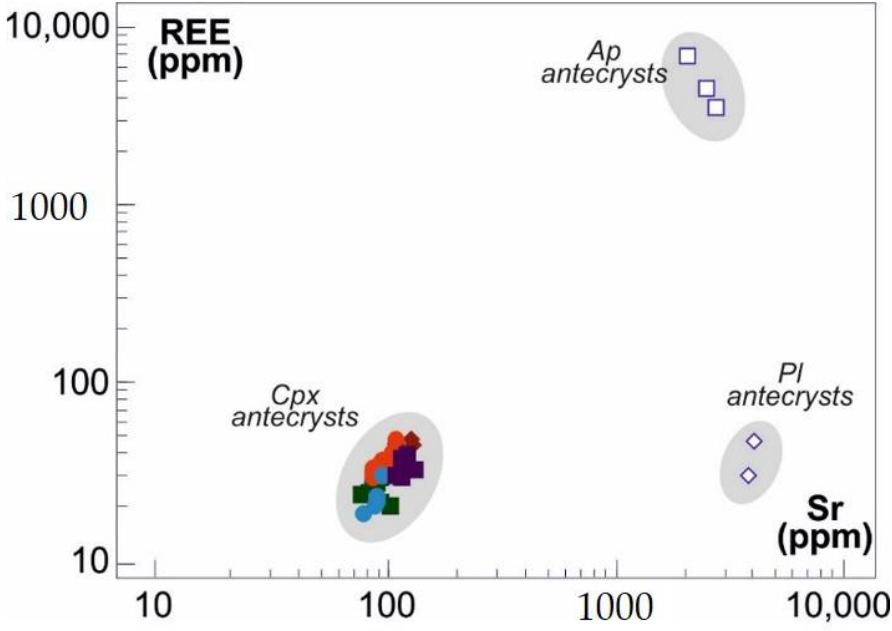
Figure 12. Diagrams of Sr (ppm) vs. REE (ppm) for PN clinopyroxene relict cores (antecrysts) compared with cumulatic plagioclase and apatite compositions in PN. Symbols of clinopyroxenes as in Figure 11.